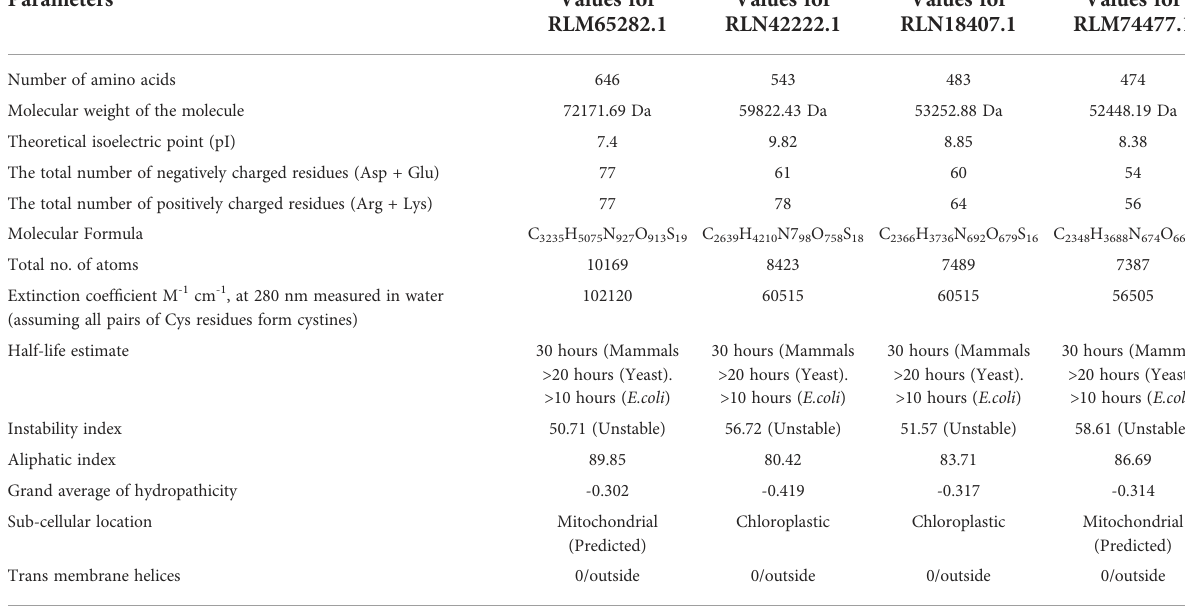
TABLE 2 Predicted physiochemical properties of selenate transporters.